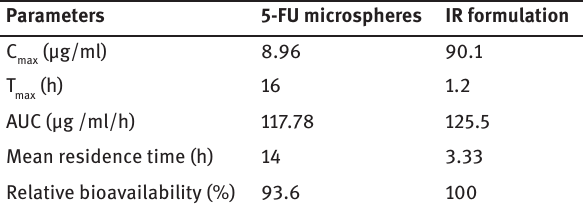
Table 1: Pharmacokinetic parameters of encapsulated 5-FU in the dual crosslinked epichlorohydrin / Portulaca mucilage hydrogel beads and the un-encapsulated (immediate release, IR) drug formulation in rat.